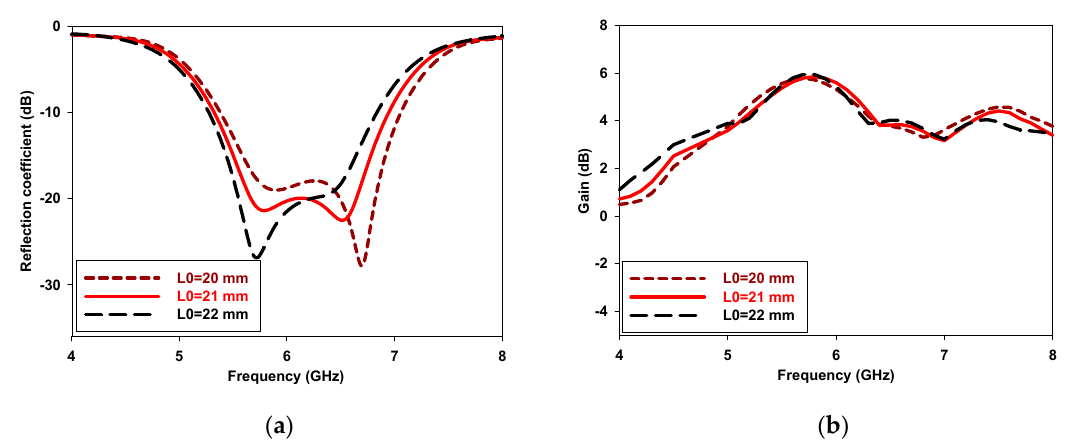
Figure 5. Simulated reflection coefficient and max gain versus the length L0: ( a ) Reflection coefficient, ( b ) Max gain.